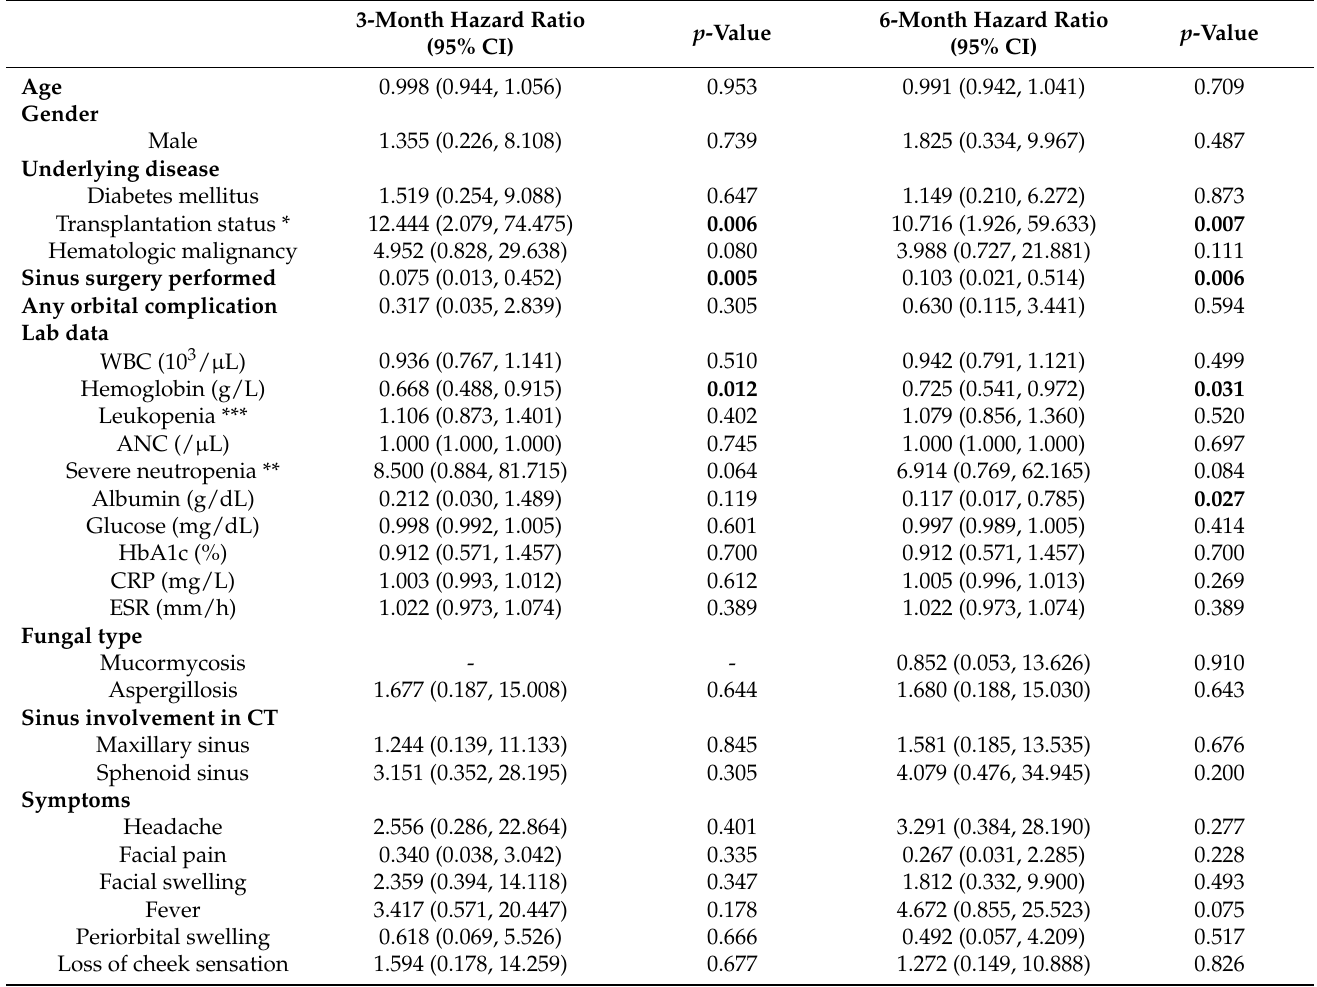
Table 6. Univariate Cox regression analysis of prognostic factors of survival in IFS patients.